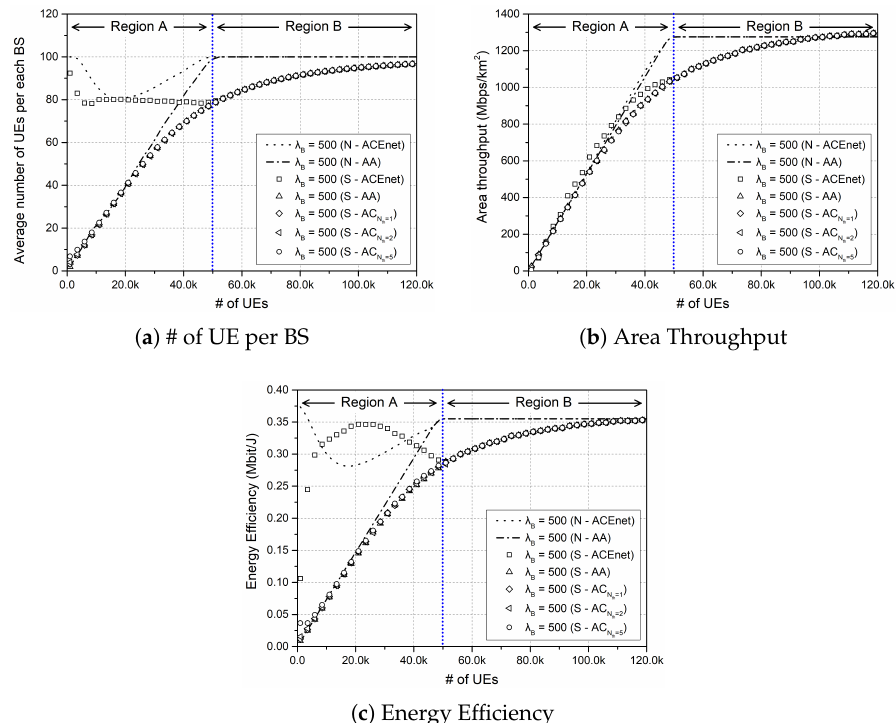
Figure 5. Average amount of UE per BS, area throughput, and energy efficiency: ACEnet vs. AA vs.